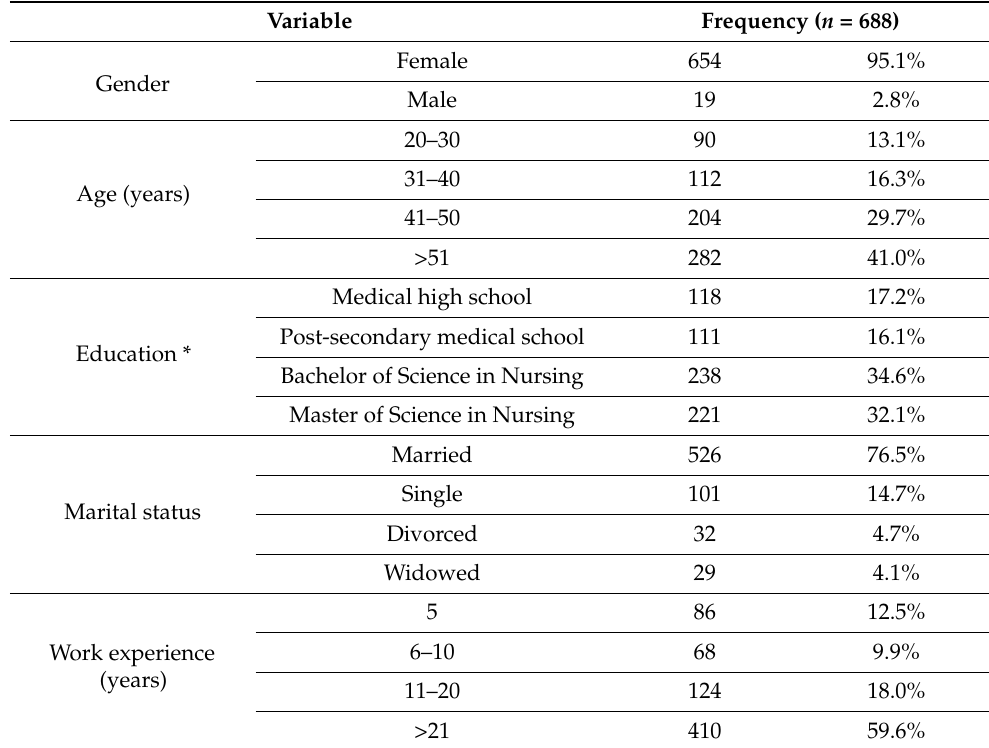
Table 1. Characteristics of the study